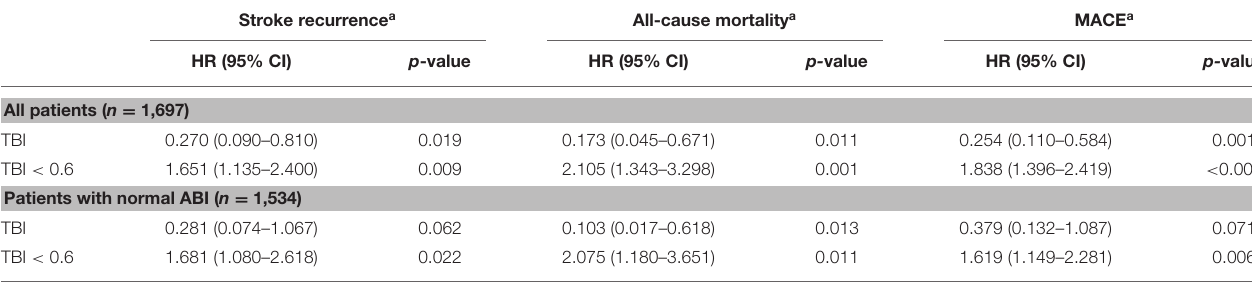
TABLE 3 | Cox proportional hazards regression analysis of TBI for long-term outcomes. Stroke recurrence